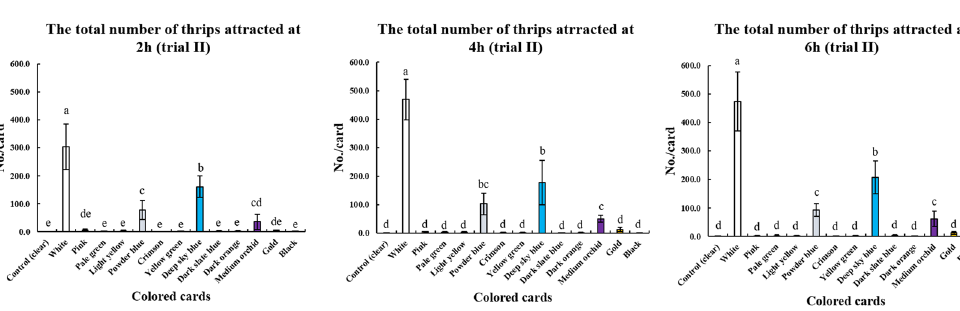
Figure 2. The attractiveness of different colored cards to thrips at 2 h, 4 h and 6 h (trial II) (mean ±